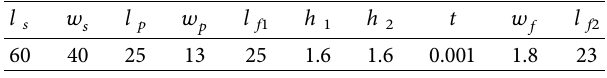
Table 1: Te dimensions of the antenna structure.